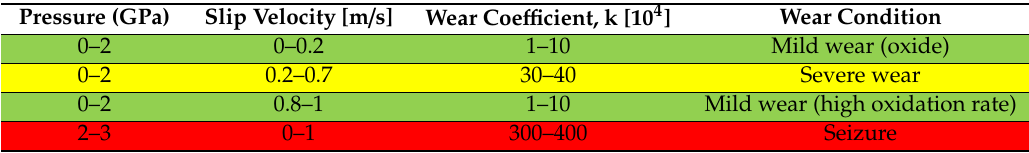
Table 3. Wear factor by contact pressure and slip velocity.